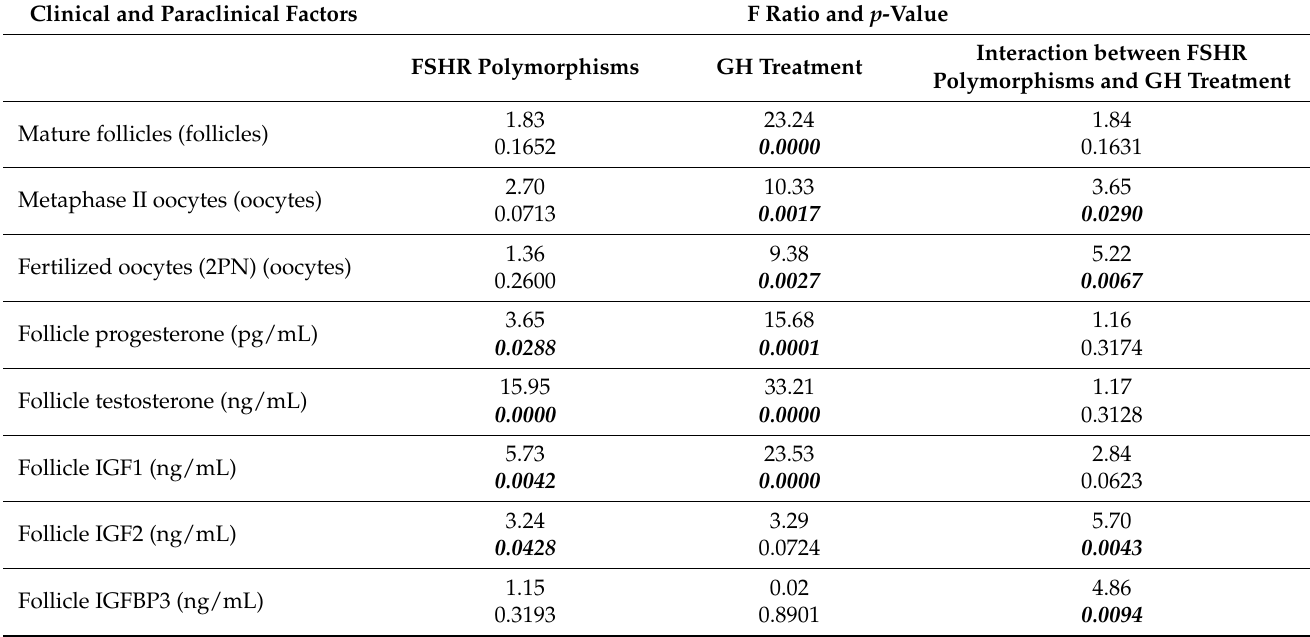
Table 5. Analysis of clinical and paraclinical factors between the FSHR polymorphisms and GH treatment.